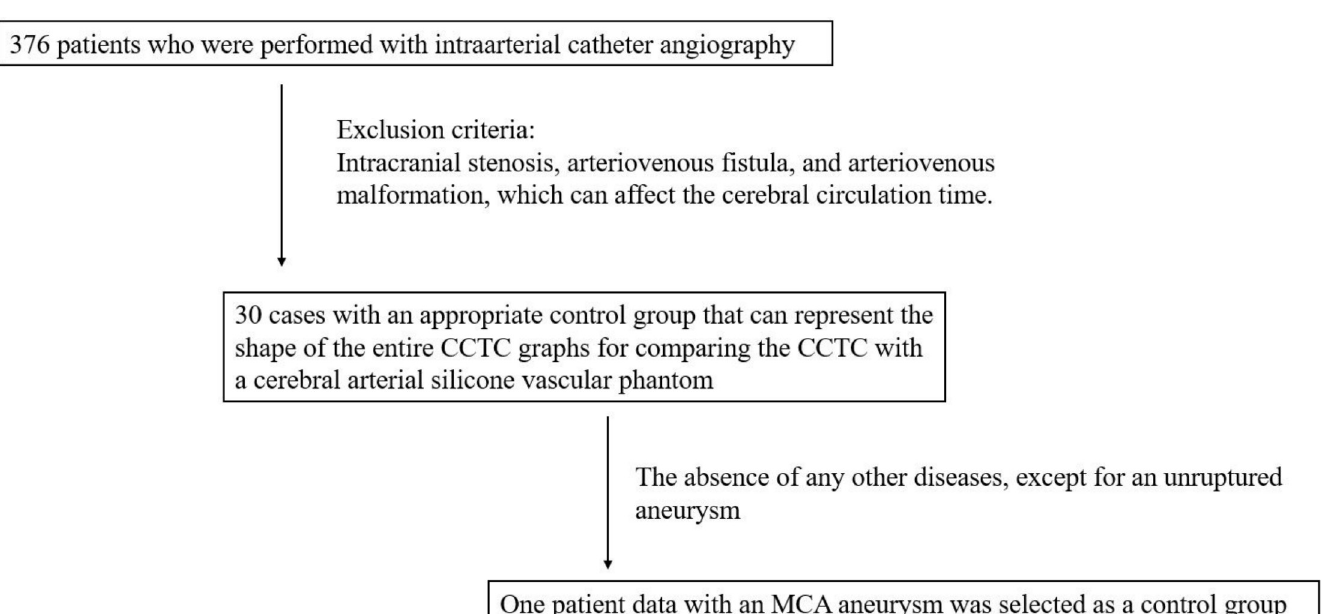
Fig 1. Flow diagram of patient